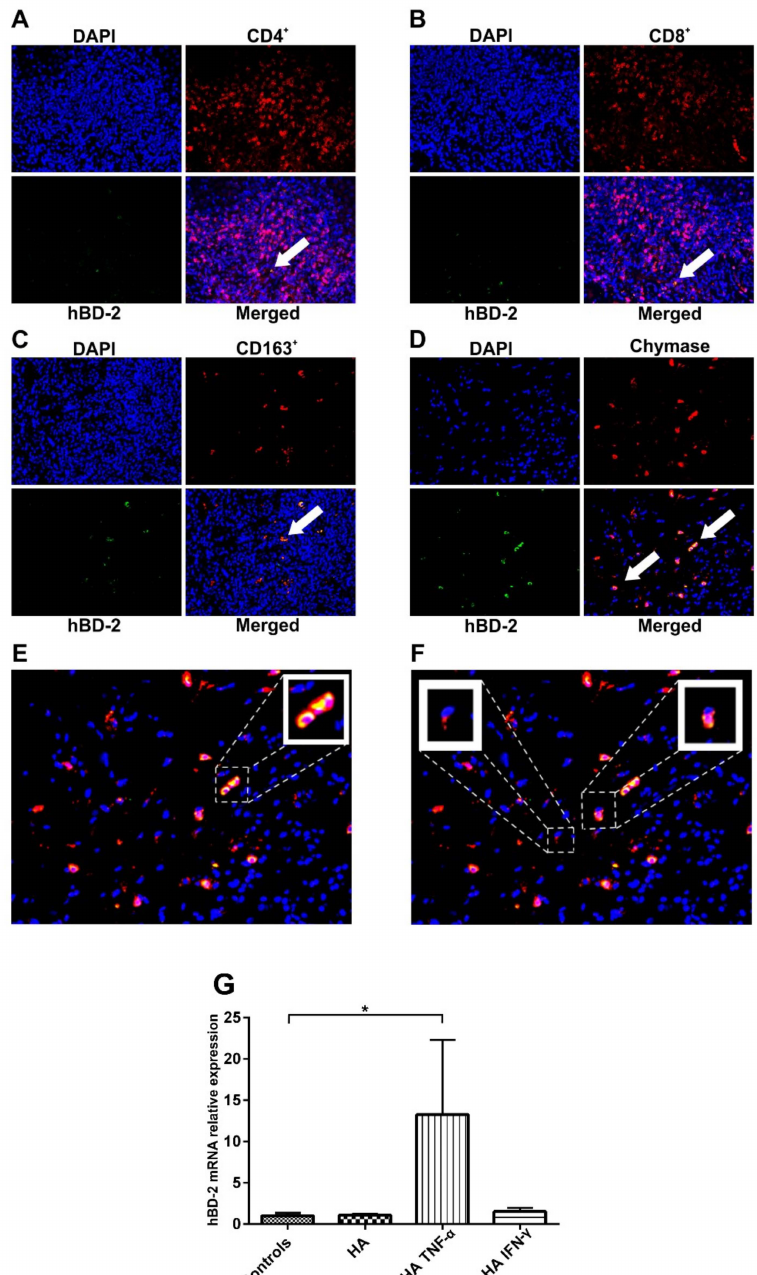
Figure 3. ( A , B ) The subepithelial inflammatory cell infiltrate was mapped by double-label immunofluorescence staining, which revealed low hBD-2-immunoreactivity (green) in cluster of differentiation 4-positive (CD4+) and CD8+ (red) T-lymphocytes. ( C , D ) On contrary, CD163+ (red) macrophages showed more hBD-2+ cells, while most of the chymase+ (red) mast cells (MCs) were hBD-2+; white arrows indicate hBD2+ cells. ( E , F ) Non-degranulated MCs were strongly positive for hBD-2 compared with the degranulated cells. Magnifications = 10 × ( A – D ), 20 × ( E , F ), and 40 × (small boxes). ( G ) Histamine alone did not have a significant effect on the hBD-2 level; however, histamine strongly promoted TNF- α -mediated, but not IFN- γ -mediated, upregulation of hBD-2 mRNA. Data are expressed as means ± SD; * p ≤ 0.05. Kruskal–Wallis test followed by Dunn’s multiple comparisons correction test was